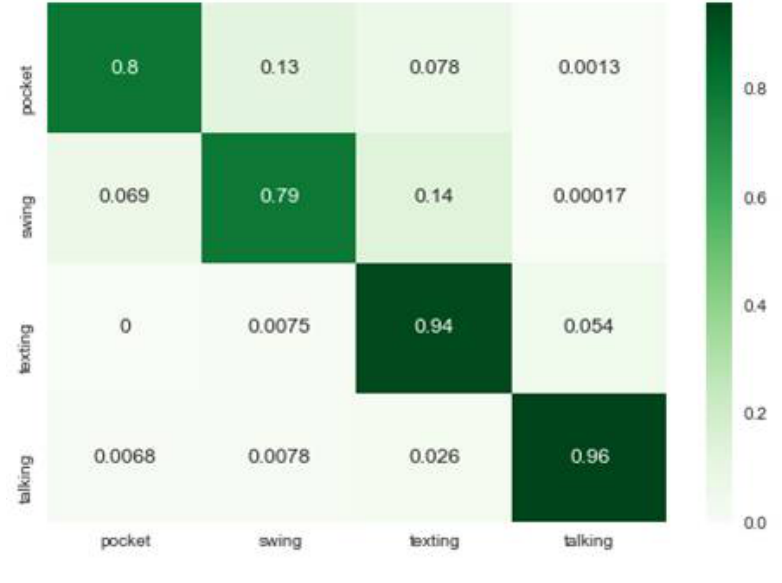
Figure 3. Confusion matrix of the four smartphone